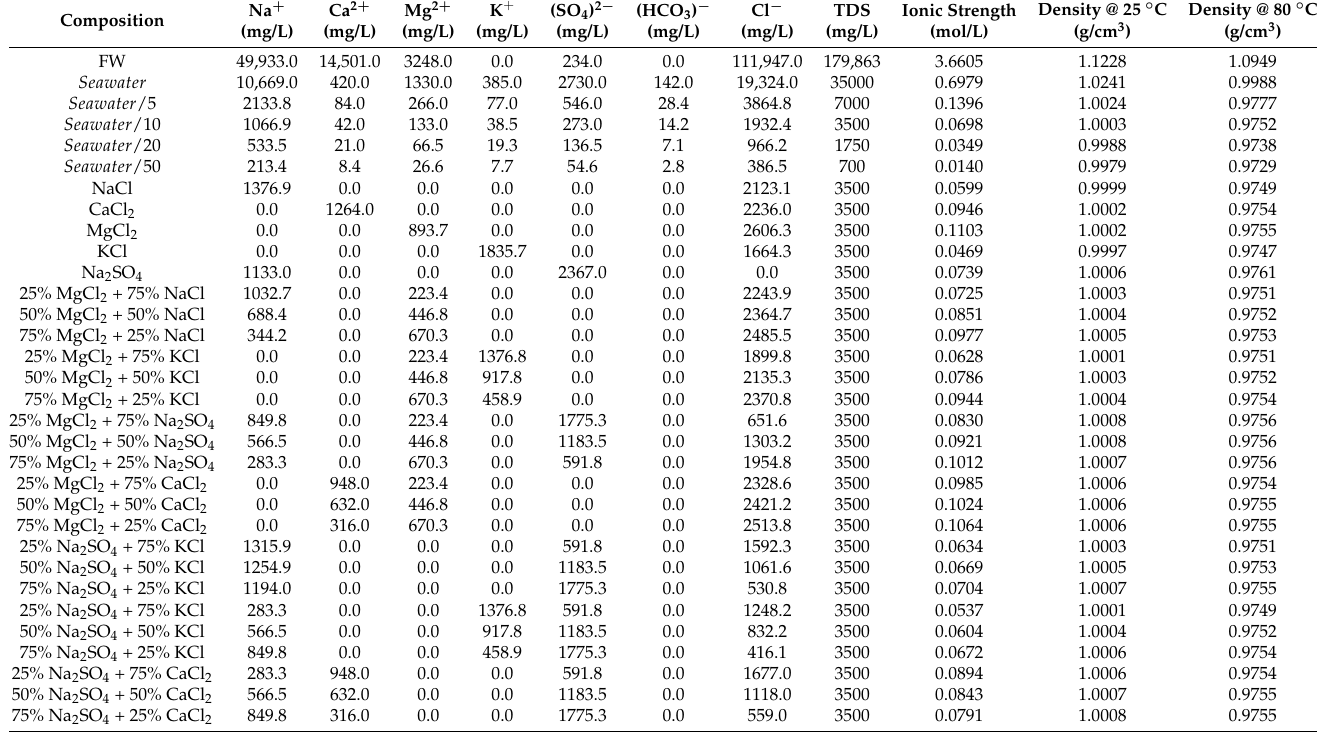
Table 3. Water-chemistry of synthetic brine solutions used in this experimental